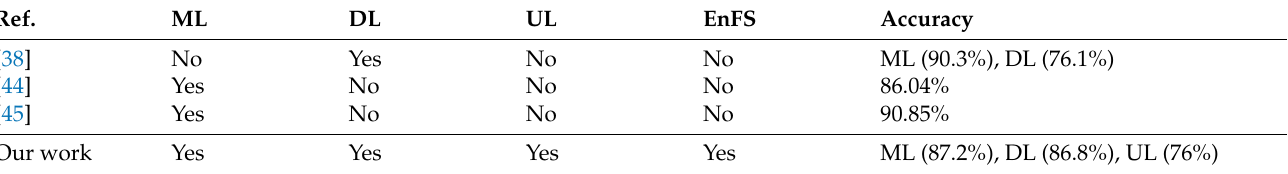
Table 13. Comparision with the existing